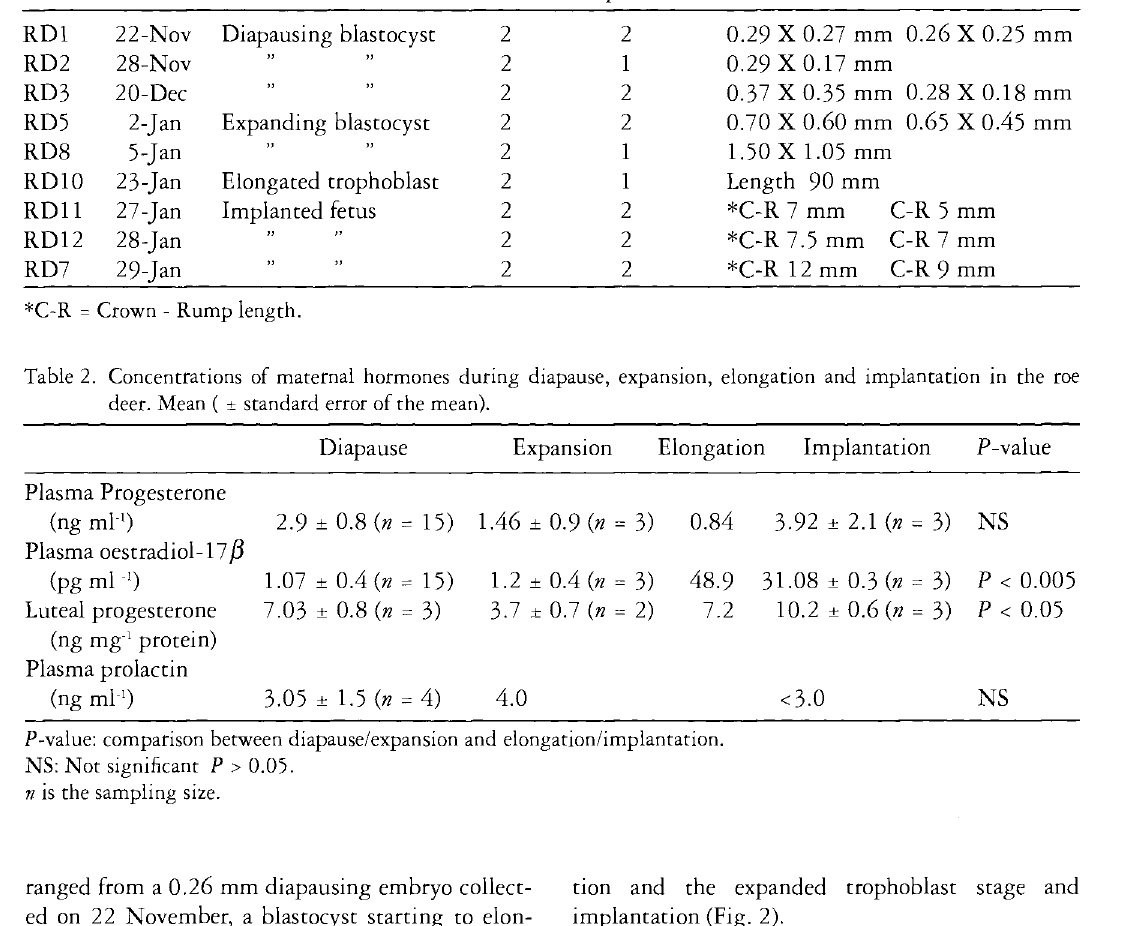
P-value: comparison between diapause/expansion and